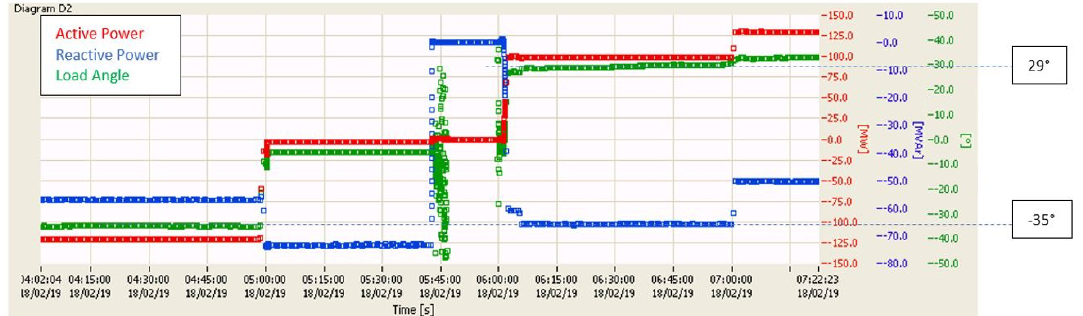
Figure 8. Change of load angle as active and reactive power change in time.